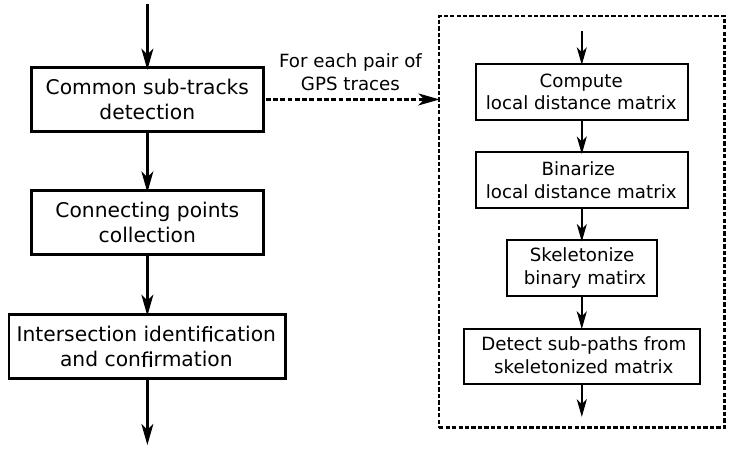
Figure 3. Overview of the proposed